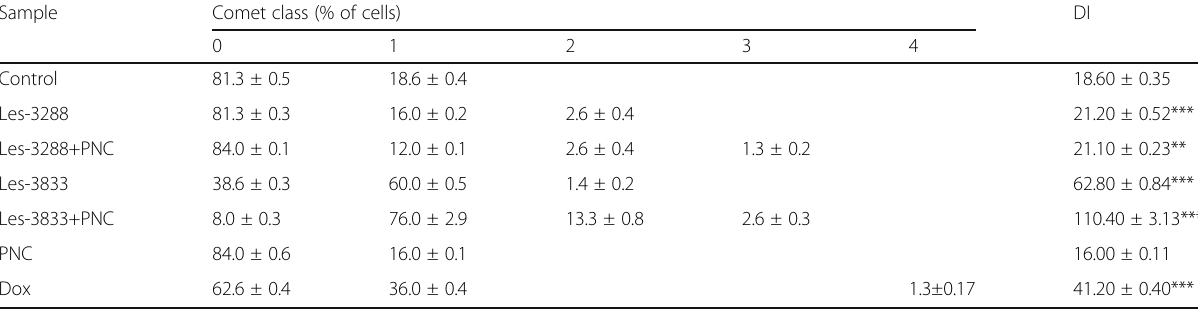
Table 2 The percentages of rat glioma C6 cells for each level of genotoxicity after 3 h of treatment with the free form of compounds Les-3288 and Les-3833, and their complexes with the polymeric nanocarrier (PNC) Sample Comet class (% of cells) DI